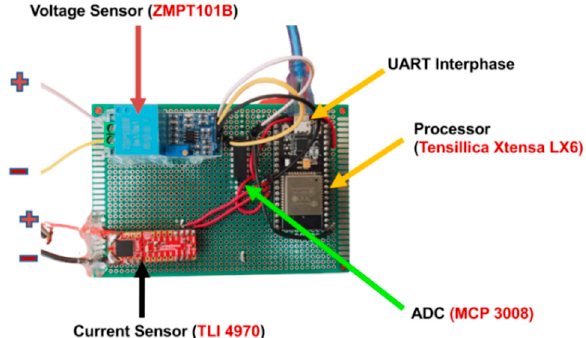
Figure 2. Stand-alone smart PQ meter.